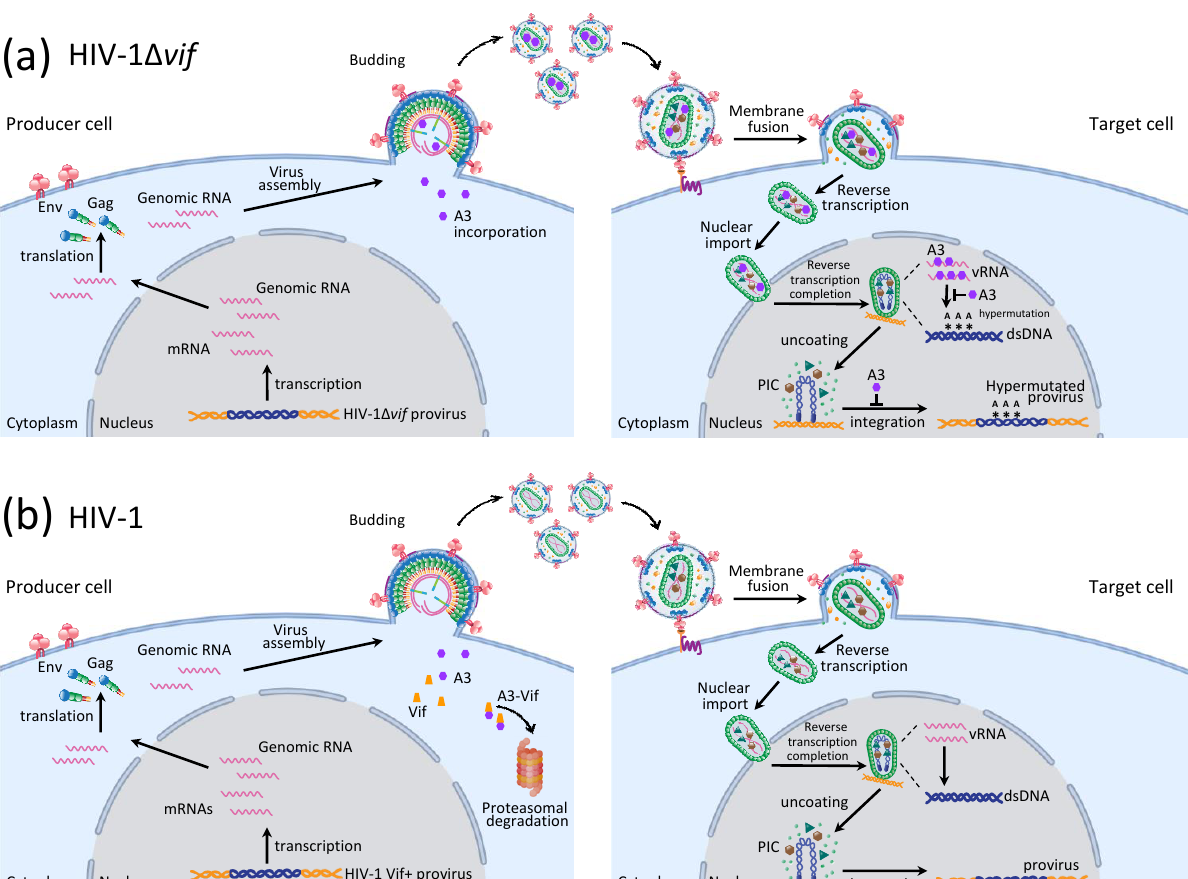
Figure 2. A3 protein-mediated HIV-1 restriction and its counteraction by Vif. ( a ) A3G inhibition of HIV-1 ∆ vif . In the absence of a functional Vif protein (HIV-1 ∆ vif ), A3G is packaged into HIV-1 virions in the producer cells, exerting its antiviral activity in the target cells by inducing lethal hypermutation, inhibiting reverse transcription and blocking integration. Reverse transcription and pre-integration complex (PIC) formation occurs within mostly intact viral cores in the cytoplasm and the nucleus [48]. ( b ) Vif induces degradation of A3 proteins. In the presence of wild-type HIV-1, expression of Vif in the producer cells targets A3 proteins for proteasomal degradation, leading to productive HIV-1 infection of target cells. Created with